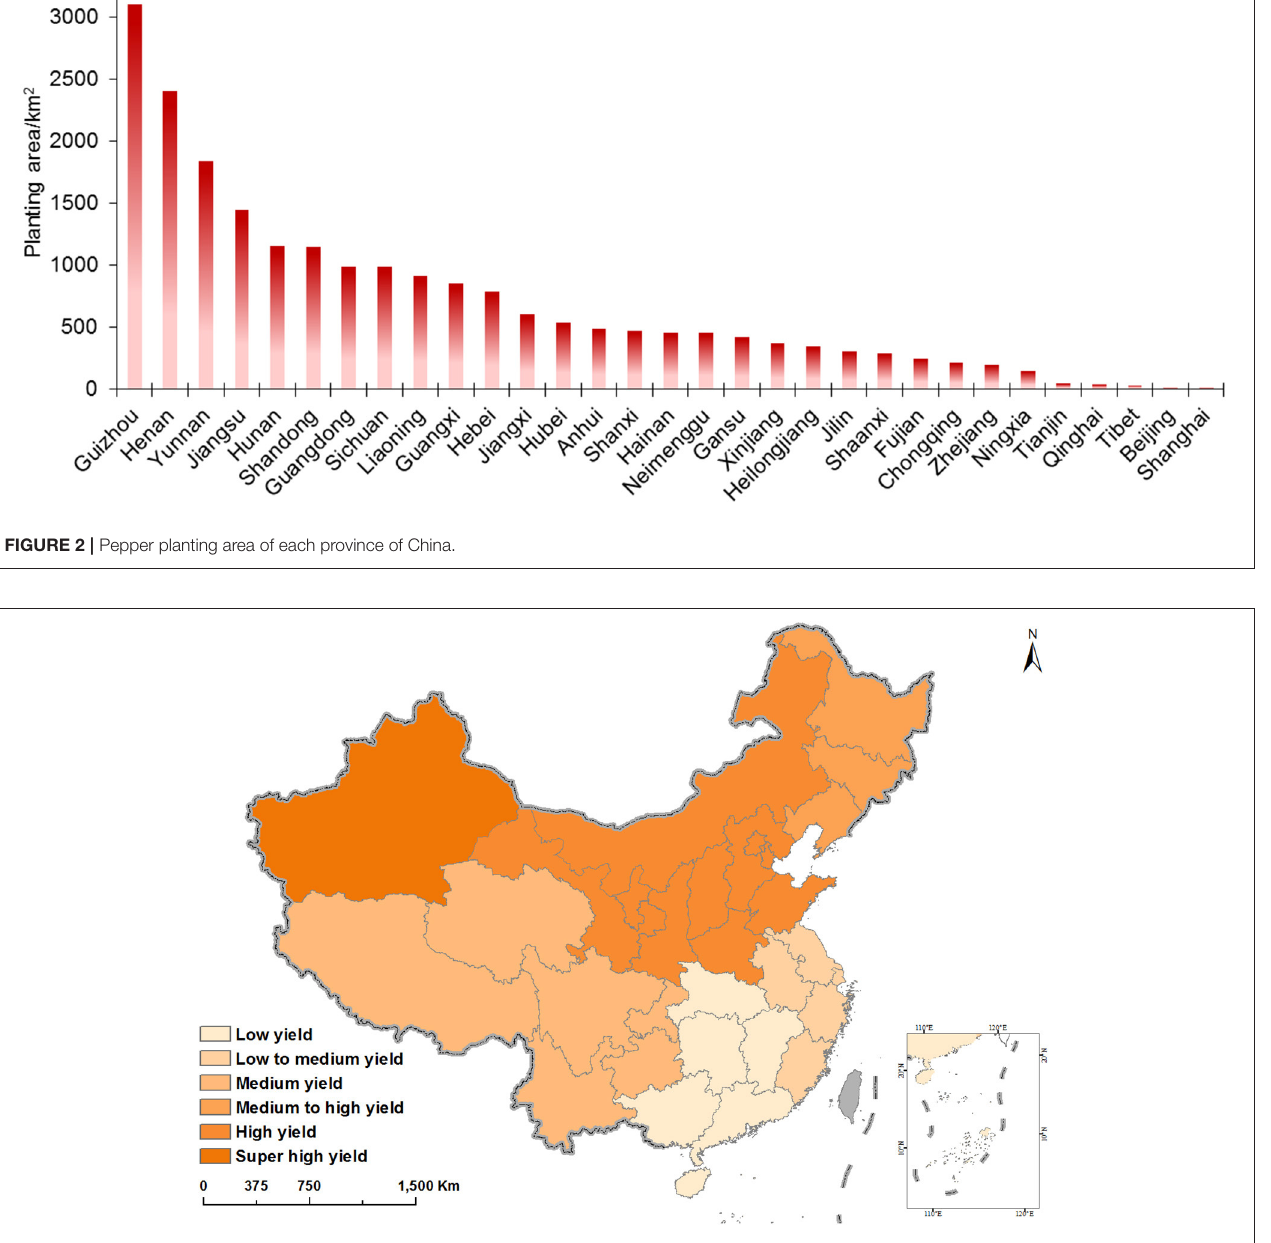
FIGURE 3 | Distribution of pepper yield in China. Data from China’s Taiwan, Hong Kong, and Macau are not